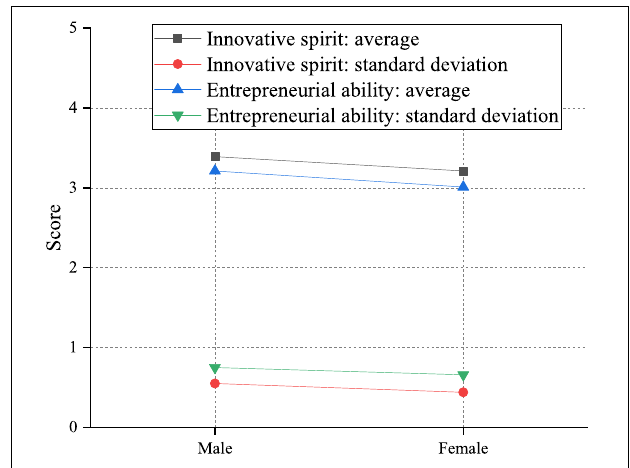
FIGURE 8 | An analysis of the impact of gender difference on innovation and entrepreneurship ability of college students.